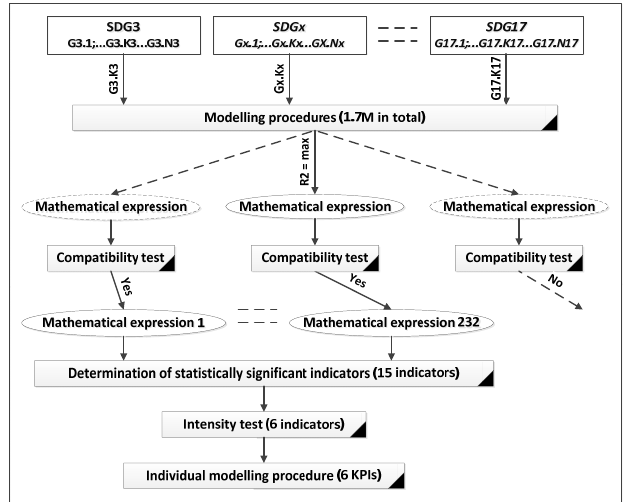
Figure 2. Linear modelling process. Developed by authors.